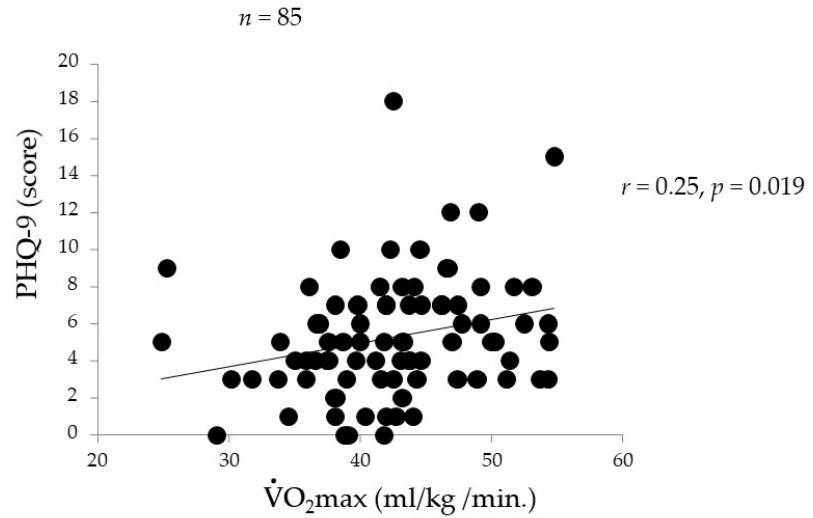
. ． VO 2 max. O 2 max.